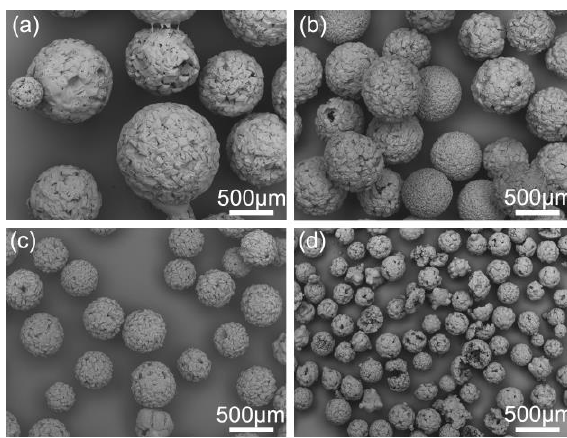
Figure 12. SEM images of the spherical crystals prepared at different stirring speeds: ( a ) 150 rpm, QESD-5; ( b ) 300 rpm, QESD-6; ( c ) 400 rpm, QESD-7; ( d ) 600 rpm,